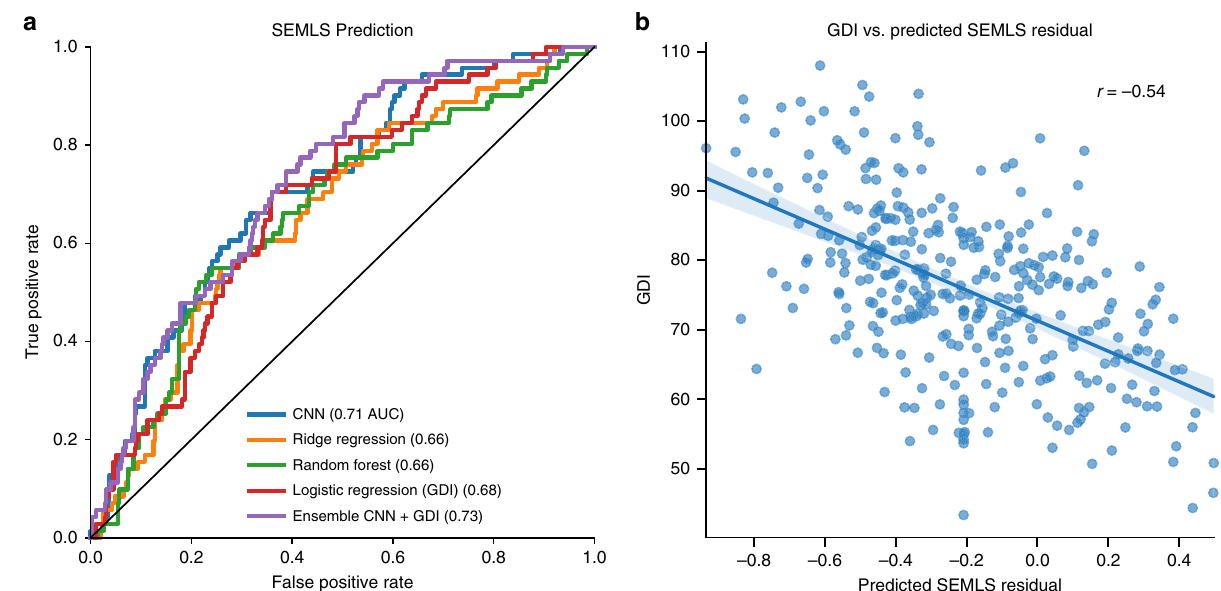
Fig. 5 Analysis of models for treatment decision prediction. a Our CNN model outperformed ridge regression and random forest models that used summary statistics of the time series (see Methods) and the logistic regression model using only GDI. b Residuals from the CNN model to predict SEMLS treatment decisions correlate with GDI. The straight blue line corresponds to the best linear fi t to predicted vs. observed data while the light band corresponds to the 95% con fi dence interval for the regression curve derived using bootstrapping ( n = 200 bootstrapping